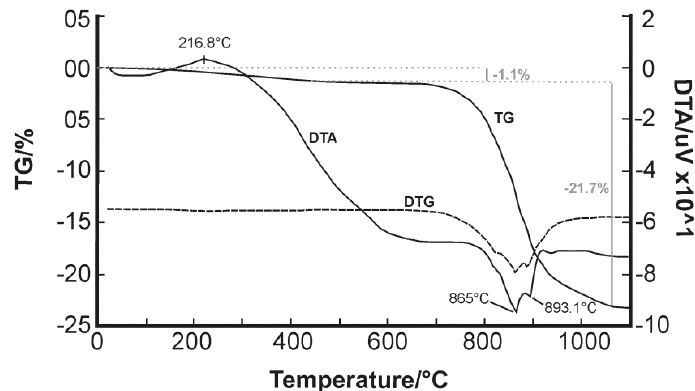
Figure 6. Characteristic DTA, TG and DTG curves for bismoclite–preisingerite pockets from San Francisco de los Andes (Sample: 05–BiOCl–02).